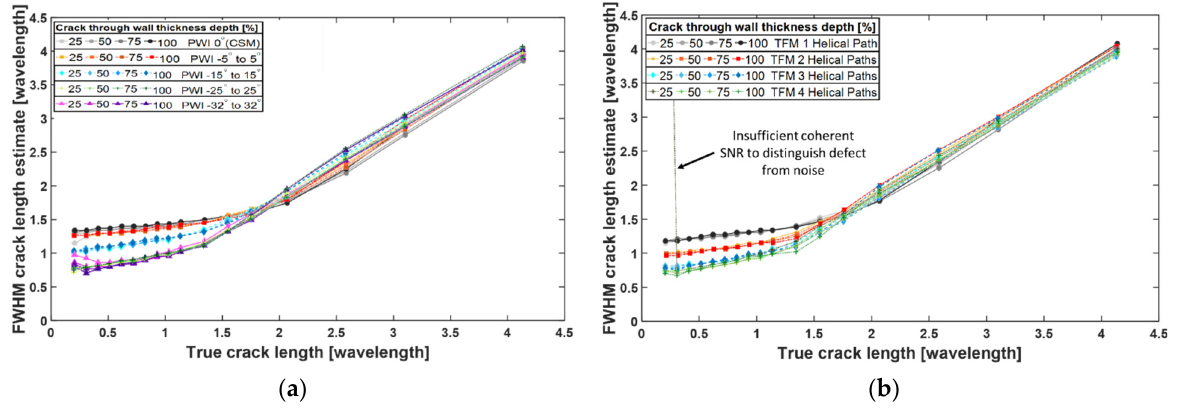
Figure A3. Plot of crack length estimates against true crack lengths measured from ( a ) PWI recon- structions using different plane wave transmission angular ranges, and ( b ) TFM reconstructions for different range of helical paths used for synthetic focusing on transmission. Based on FE simula- tions.